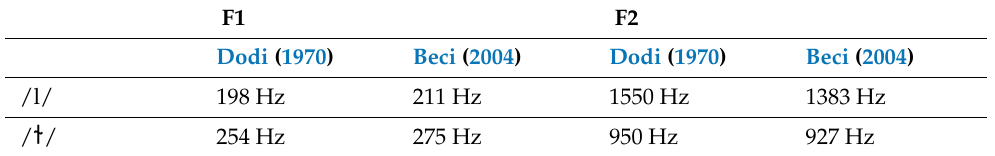
Table 1. F1 and F2 values for /l/ and / ɫ /. F1 F2 Dodi (1970) Beci